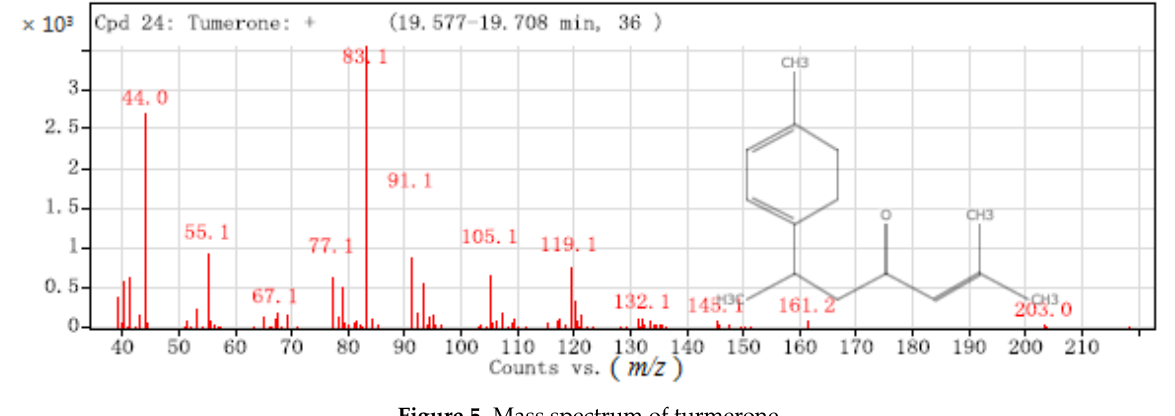
Figure 5. Mass spectrum of turmerone.